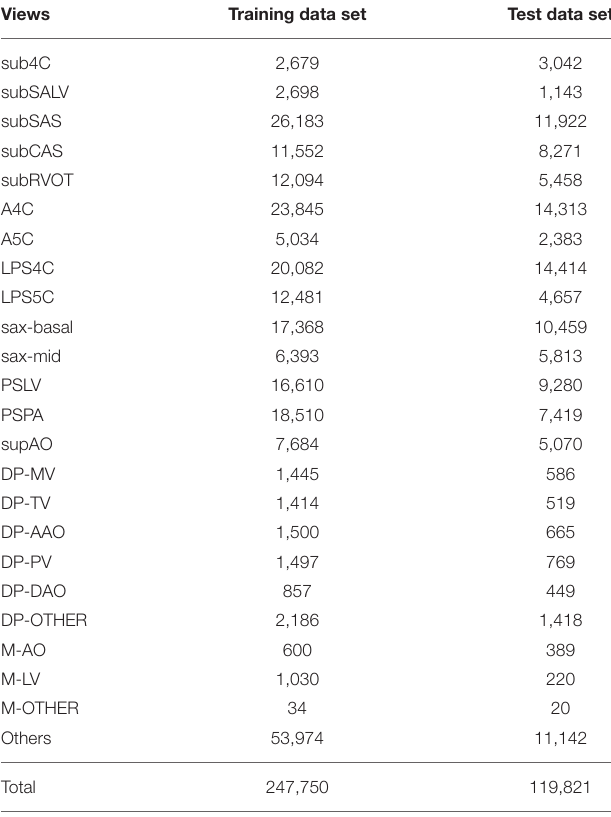
TABLE 1 | View distribution of our data.